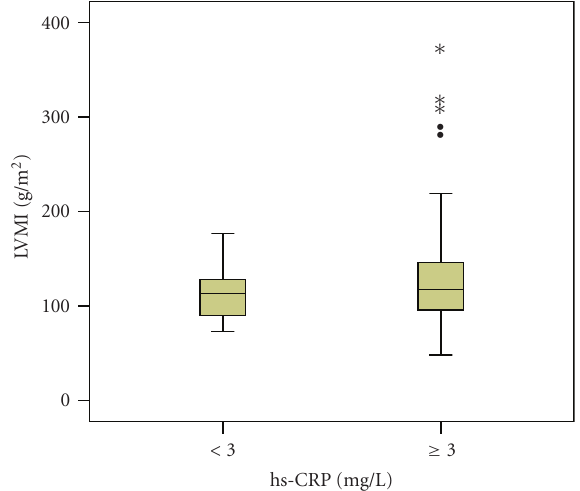
Figure 1: Comparison of LVMI in two groups divided by hs-CRP cuto ff